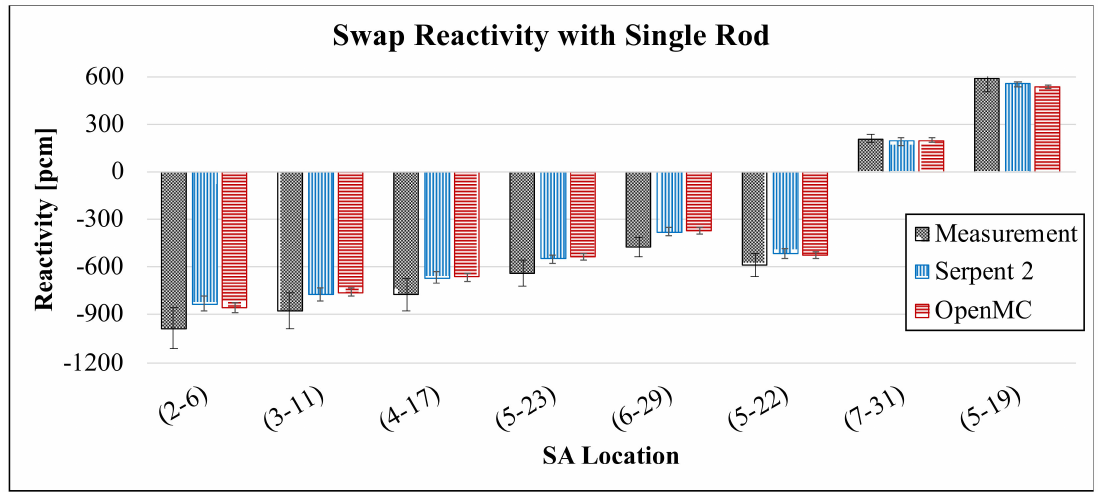
Figure 17. Comparison of swap reactivity results: test case of single